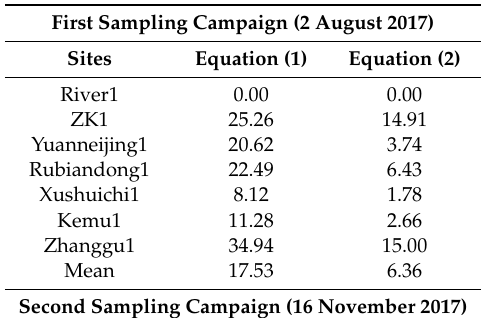
Table 4. Apparent radium ages of the water samples (1 represents the first sampling, and 2 represents the second sampling). Unit: